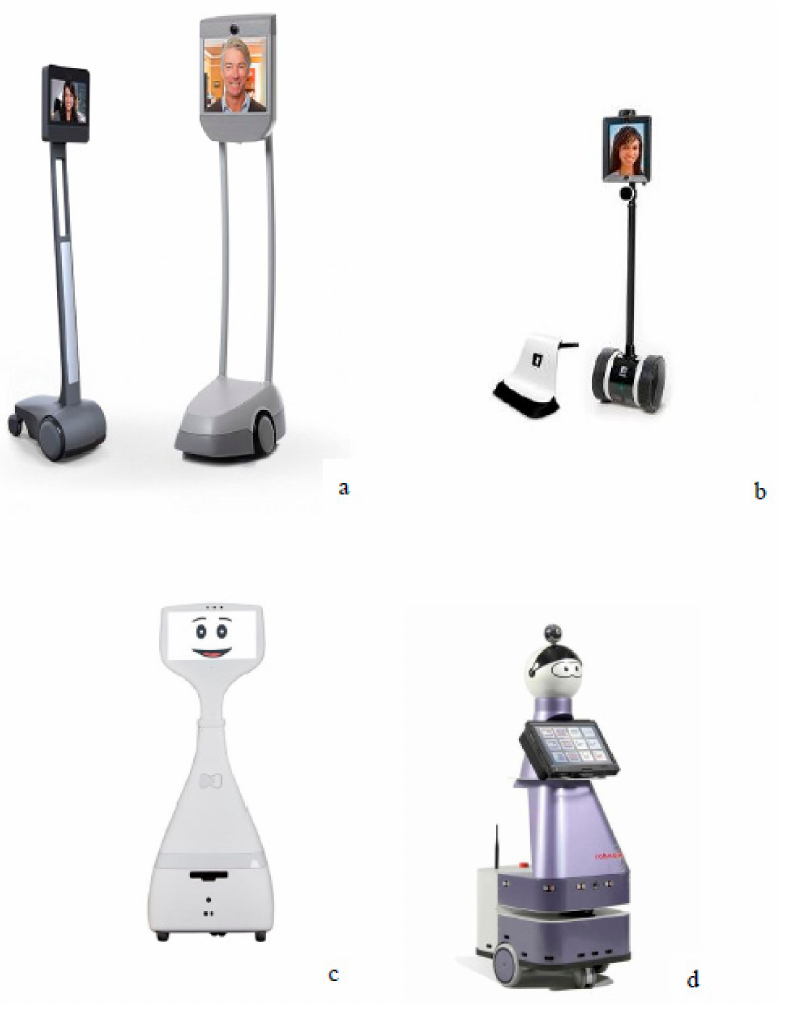
Figure 1. Examples of telepresence robots: ( a ) Beam + [21]; ( b ) Double 3 [22]; ( c ) Cutii [23]; ( d ) Kompai